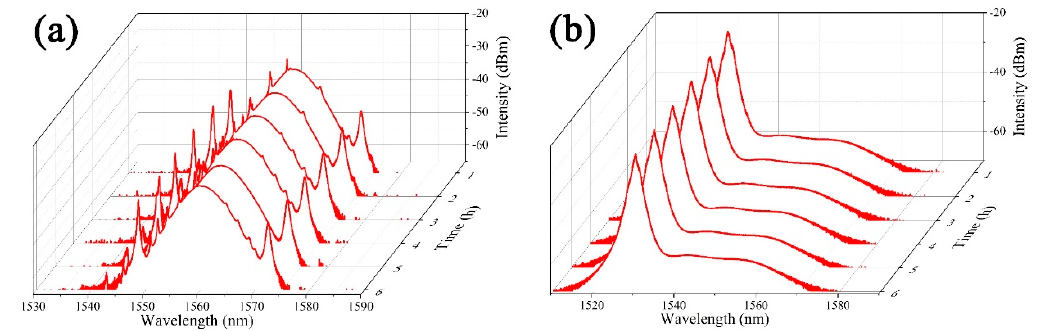
Figure 6. Nonlinear saturable absorption of ML CNT-SA and BL CNT-SA using homemade I-scan system.